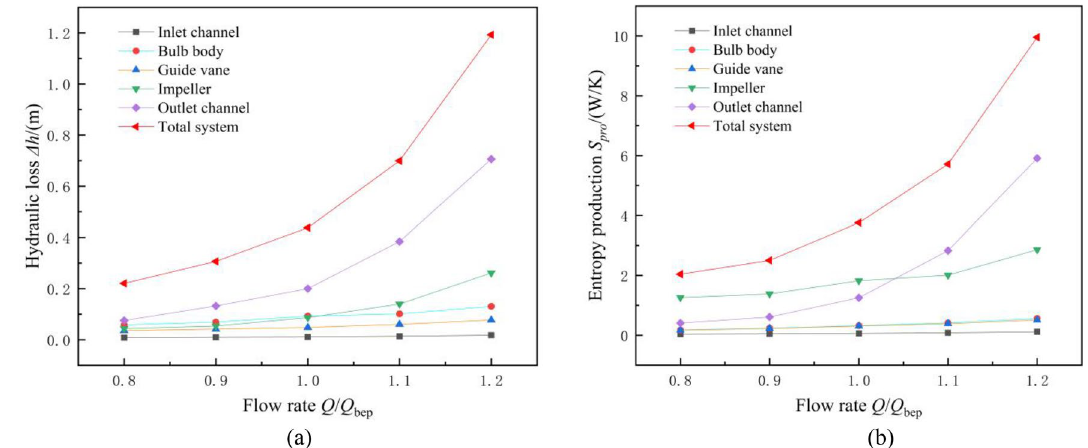
Figure 6. Distribution of the energy loss in the system under different flow conditions. ( a ) Distribution of the hydraulic loss in each region (pressure drop method), ( b ) Distribution of the total entropy production in each region (entropy production method).